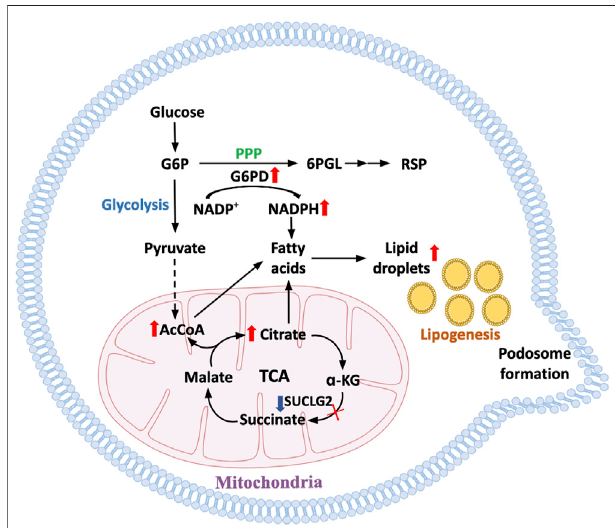
FIGURE 3 | Metabolic pathways underlying enhanced cell motility in aged T cells. With progressive age, T cells become hypermobile and tissue invasive, facilitating theirroleintissuein fl ammation. InTcellsfrom prematurely aged patients with the autoimmune disease rheumatoid arthritis, mechanisms underlying the propensity of T cell invasiveness have been de fi ned. Metabolic restructuring shifting glucose away from glycolytic breakdown tothe pentose phosphate pathway promotes NADPH production and lipogenesis. Accumulation of intracellular lipids is enhanced by mitochondrial failure and disruption of beta oxidation. Lipid droplets serve as reservoirs for membrane formation, equipping the cells with invasive membrane structures and turning T cells into highly invasive, in fl ammatory effector cells.